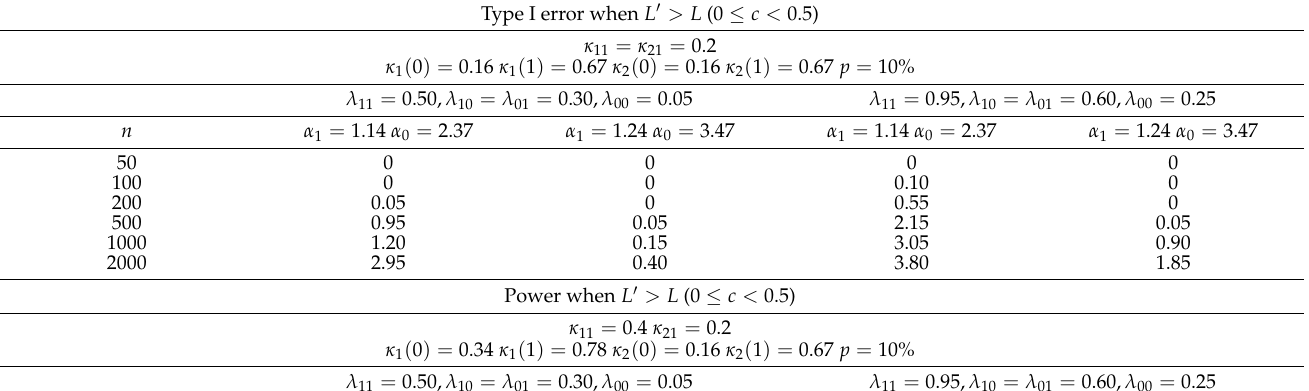
Table 9. Type I errors (in%) and powers (in%) applying multiple imputation. Type I error when L (cid:48) > L (0 ≤ c <